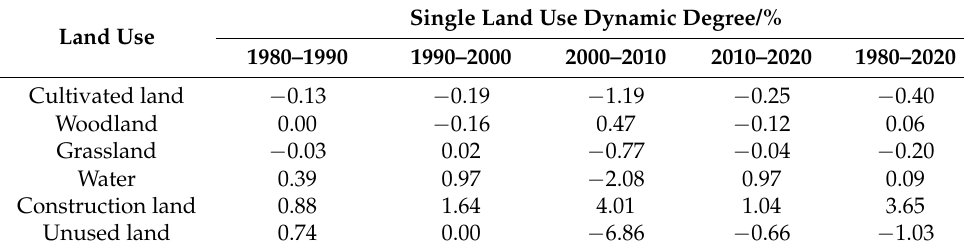
Table 3. Single landscape dynamics in Taiyuan City from 1980 to